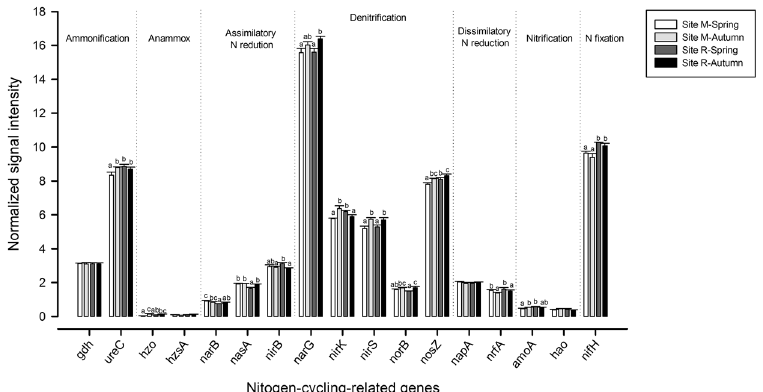
Figure 6. Normalized signal intensity of key genes involved in N cycling detected using Geochip 5.0 and found at the deciduous forest site M (545–570 m asl) and the coniferous forest site R (1,724–1,737 m) in spring and autumn. The genes were grouped according to their functional role in N cycling. For each gene, values followed by different letters are significantly different (p ≤ 0.05) according to Tukey’s HSD test. Statistical analyses were indicated only in genes showing significant differences. Bars represent standard